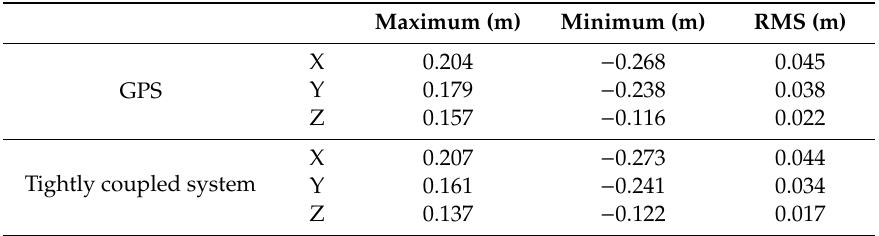
Table 2. The statistical results of position errors of GPS and the tightly coupled system.